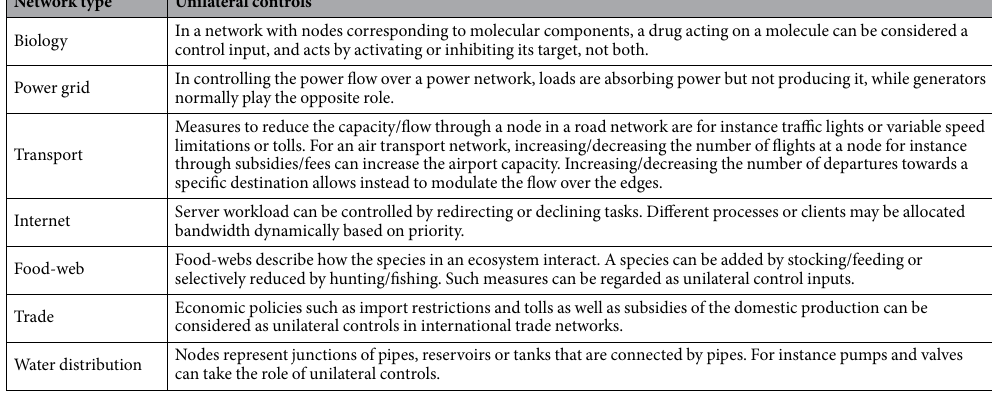
Table 1. Application areas with naturally unilateral control inputs. For each of the classes of networks listed in the table, examples of constrained controls are provided. Most often these constraints take the form of unilateral